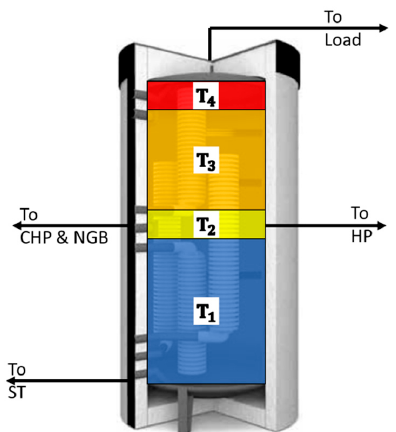
Figure 5. Schematic representation of the division of the heat storage into four zones, each with its own approximation model.